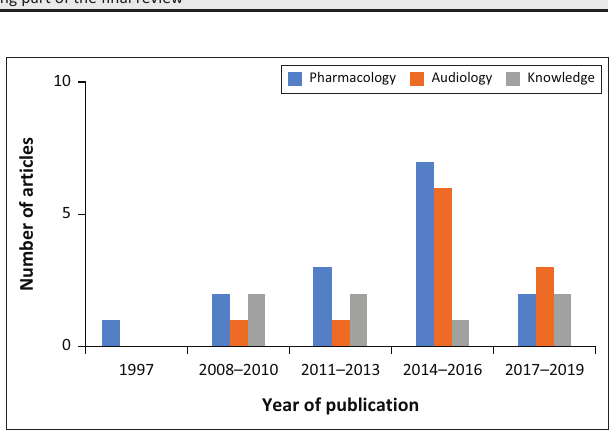
FIGURE 1: Chronological pattern of